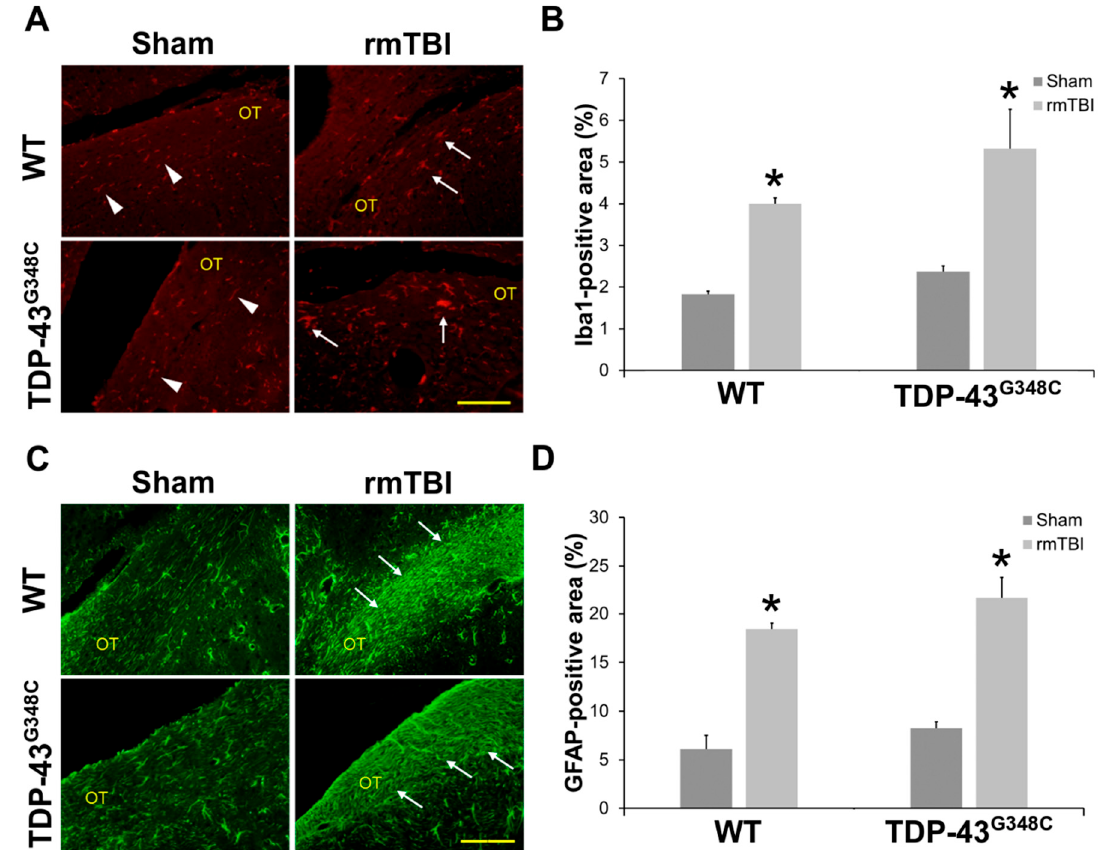
Figure 5. Gliosis at 6 months after repetitive mild traumatic brain injury (rmTBI) in the optic tract (OT) of wild-type (WT) and TDP-43 G348C mice. ( A ) Representative microphotographs of the OT immunostained with anti-ionized calcium-binding adaptor molecule 1 (Iba1). Arrowheads point to Iba1-positive cells with “resting” microglial morphology, and arrows point to Iba1-positive cells with activated microglial morphology. Scale bar: 100 µ m. ( B ) The histogram shows the Iba1-positive area (%) in the OT of WT and TDP-43 G348C mice with rmTBI and related control groups (Sham). Results are expressed as means ± SEM ( N = 5). * p < 0.05, significantly different from the related Sham. ( C ) Representative microphotographs of the OT immunostained with anti-glial fibrillary acidic protein (GFAP). Arrows point to the GFAP-positive cells with hypertrophic morphology. Scale bar: 100 µ m. ( D ) The histogram shows the GFAP-positive area (%) in the OT of WT and TDP-43 G348C mice with rmTBI and related control groups (Sham). Results are expressed as means ± SEM ( N = 5). * p < 0.05, significantly different from the related